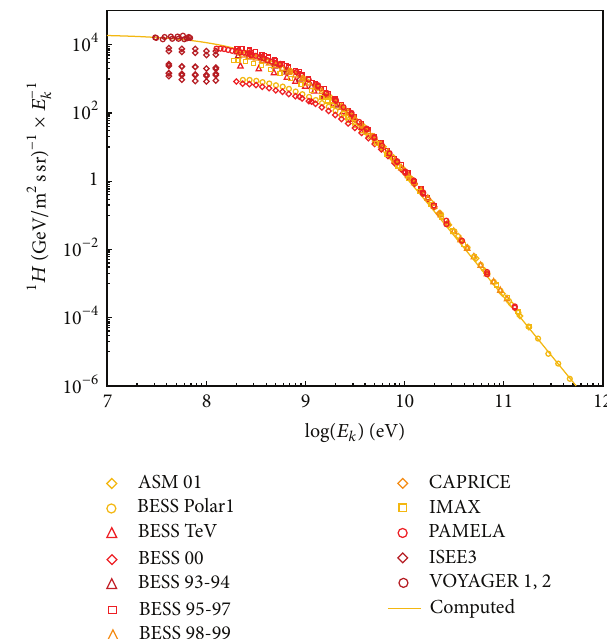
Figure 5: Proton flux 𝐹 versus energy 𝐸 𝑘 compiled from many measurements, available from Database of Charged Cosmic Rays [79] (see text for references), displays the low-energy spectrum about the flux maximum that is governed by the proton rest energy = 𝑚 𝑐 2 ≈ 10 9 eV. The computed line (orange line) has been 𝐸 𝑜 𝑝 scaled in energy to match the data to reveal that the proton flux with decreasing energy originates from more and more distant sources in the expanding part of the Universe.